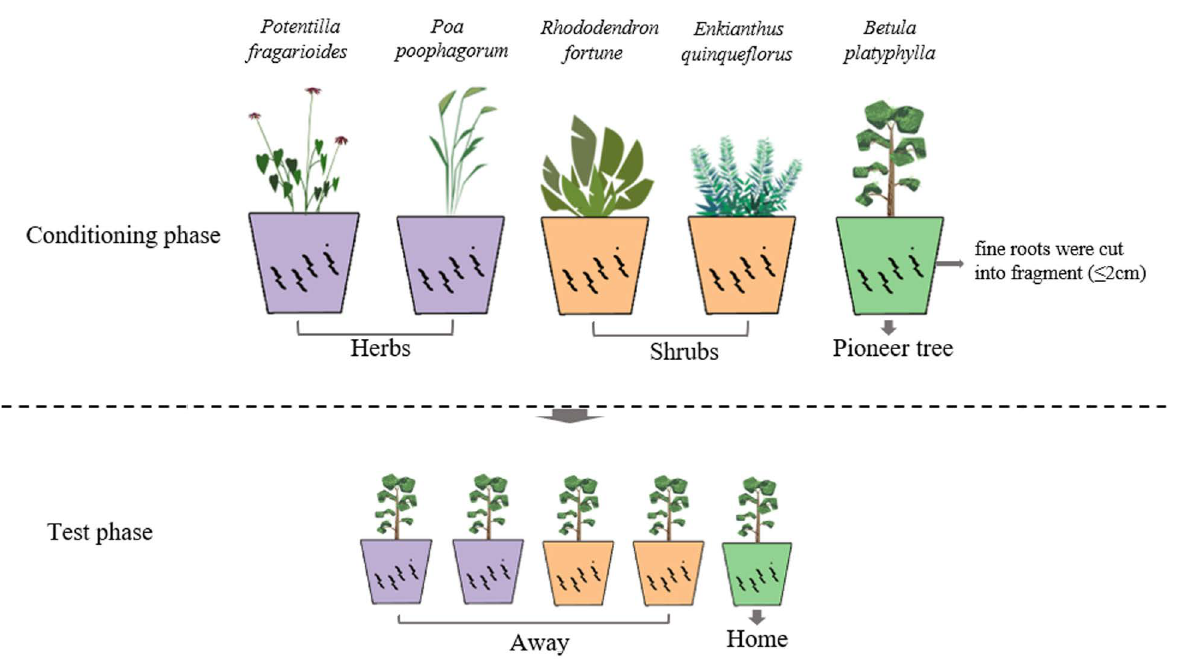
Figure 1. Graphical illustration of the experimental design. In the conditioning phase, five different plant species, PF: Potentilla fragarioides L., PP: Poa poophagorum Bor, RF: Rhododendron fortune Lindl., EQ: Enkianthus quinqueflorus Lour., BP: Betula platyphylla Sukaczev, were monocultured in soils created by 90% sterilized bare soil and 10% specific inoculum. In the test phase, Betula platyphylla was monocultured in preconditioned